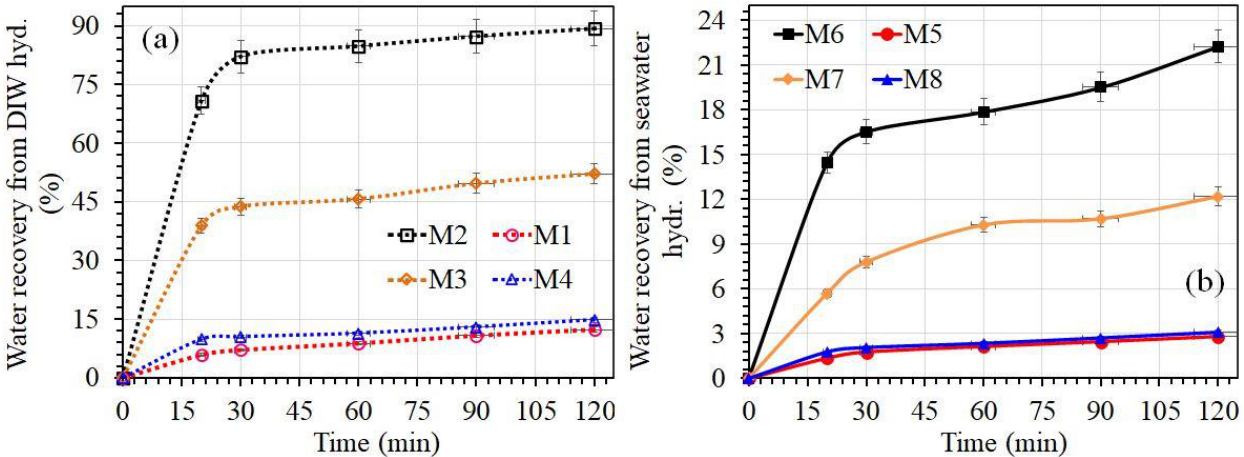
Figure 7. Water recovery from two different liquids ( a ) DIW; ( b ) Seawater with and without pro- moters.